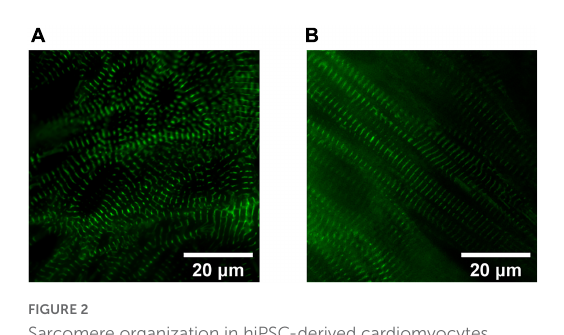
FIGURE2 Sarcomere organization in hiPSC-derived cardiomyocytes (CMs). Widefield fluorescence images (Videos of beating CMs available) of 1 Hz paced hiPSC-derived CMs expressing mEGFP-labeled α -actinin-2 at sarcomeric z-disks (cell line ID: AICS-0075 cl.85). (A) Human iPSC-CMs cultured for 40 days in RPMI1640/B27 have less sarcomeric organization compared to (B) Day 40 human induced pluripotent stem cell-derived cardiomyocytes (hiPSC-CMs) treated for 4 weeks in a metabolic maturation media (MM).